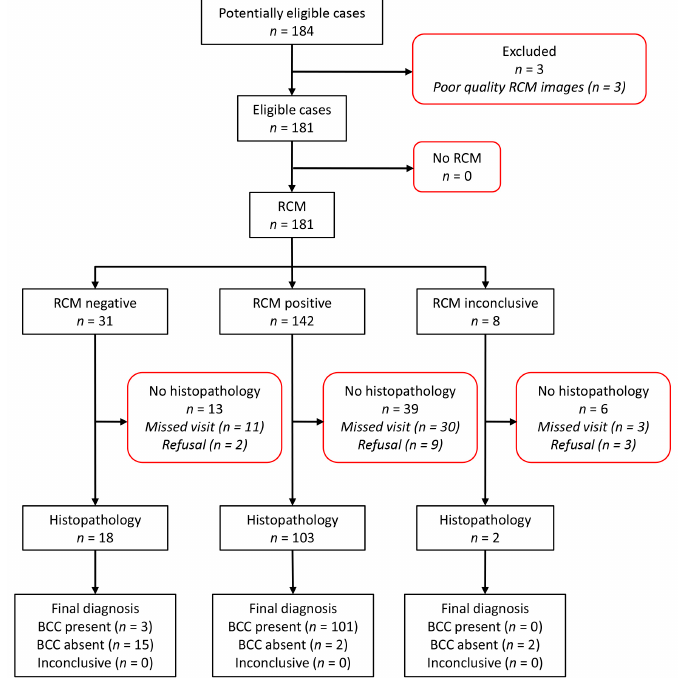
Figure 1. Diagram showing case selection process. RCM: reflectance confocal microscopy; BCC: basal cell carcinoma.